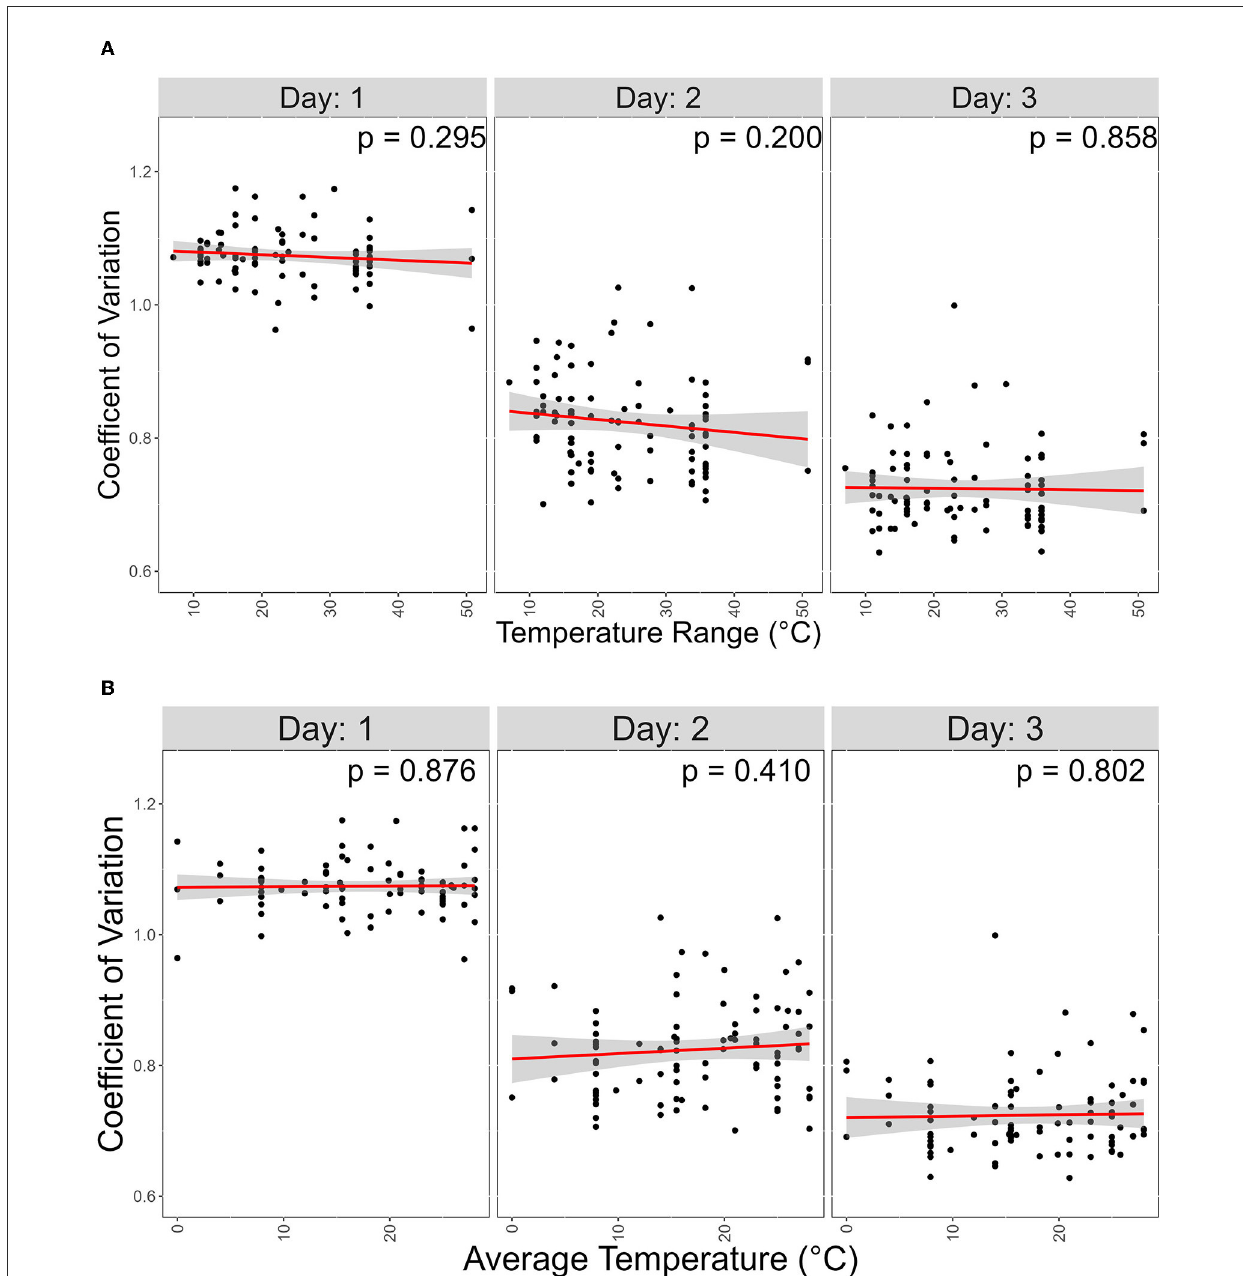
FIGURE7 Atmospheric temperature at isolation sites has no significant contribution on coefficient of variation (CV). X-axis represents temperature range; Y-axis represents coefficient variations. Linear regression was used to determine signifcance between the two variables. (A) Scater plot of the effect of the Average temperature of each isolation site on CV. (B) Scater plot of the effect of the temperature range, which is the difference between the high and lowest average temperature of each isolation site, on